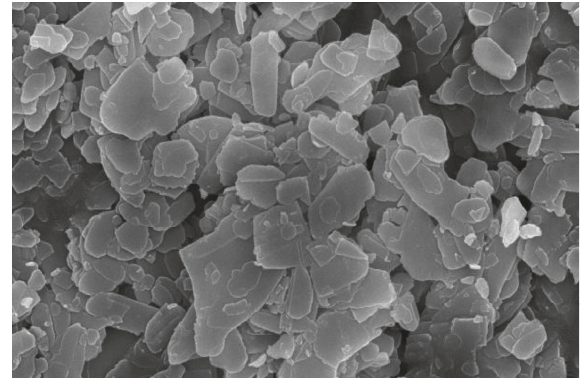
Figure 2: SEM micrograph of WMP.